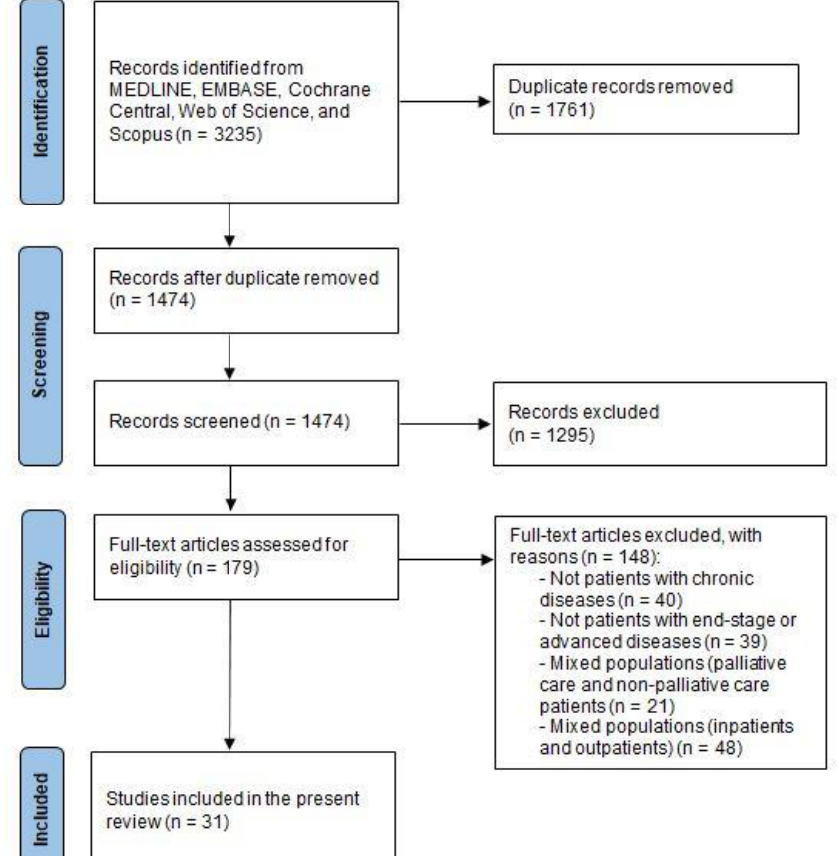
Figure 1. PRISMA flow diagram.